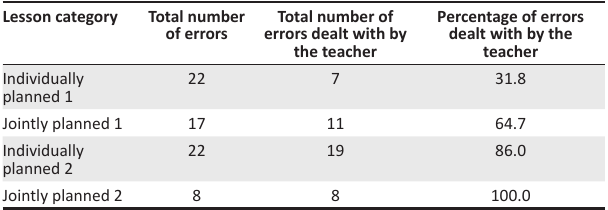
TABLE 5: Number and percentage of errors dealt with by the teacher per lesson category. Lesson